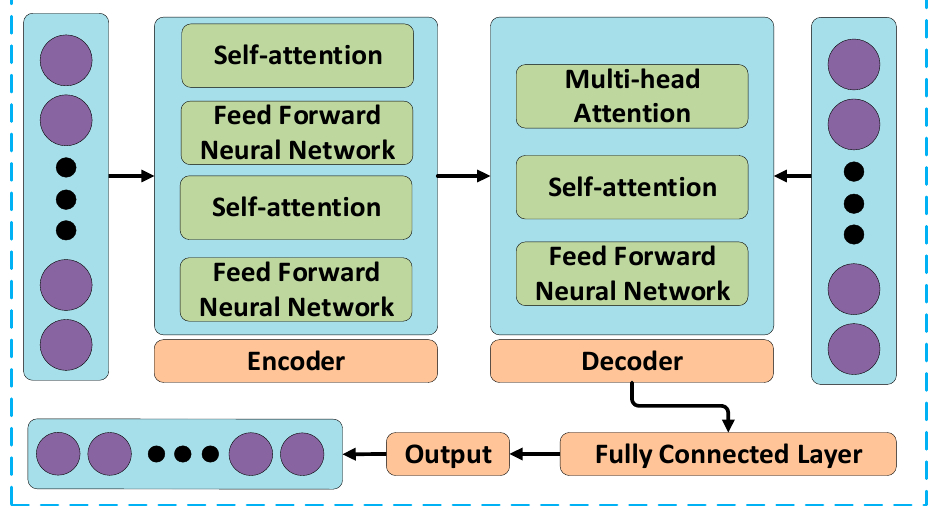
Figure 5. The architecture of encoder and decoder.